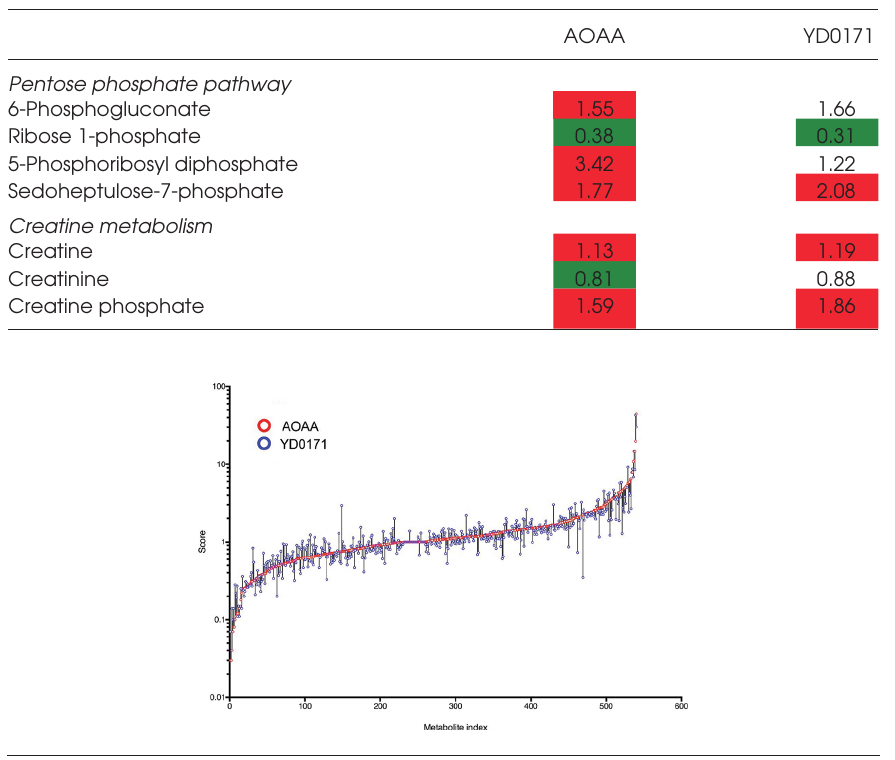
Figure 6. Effect of YD0171 on the metabolome of HCT116 cells. Cells were treated with YD0171 (1 mmol/L) or AOAA (1 mmol/L) for 24 h followed by metabolomic analysis. The horizontal scale shows analyte numbers. The vertical scale shows fold change; the value of 1 represents no change, a value of 0.1 represents a 90% decrease in the analyte value, a value of 10 represents a 10-fold increase in the analyte value in response to AOAA (red circles) or YD0171 (blue circles) treatment, was compared with vehicle control. Overlapping, circles or circles connected with short vertical black lines indicate that AOAA and YD0171 affected the analyte in a directionally similar way. Data are shown as mean values of n =